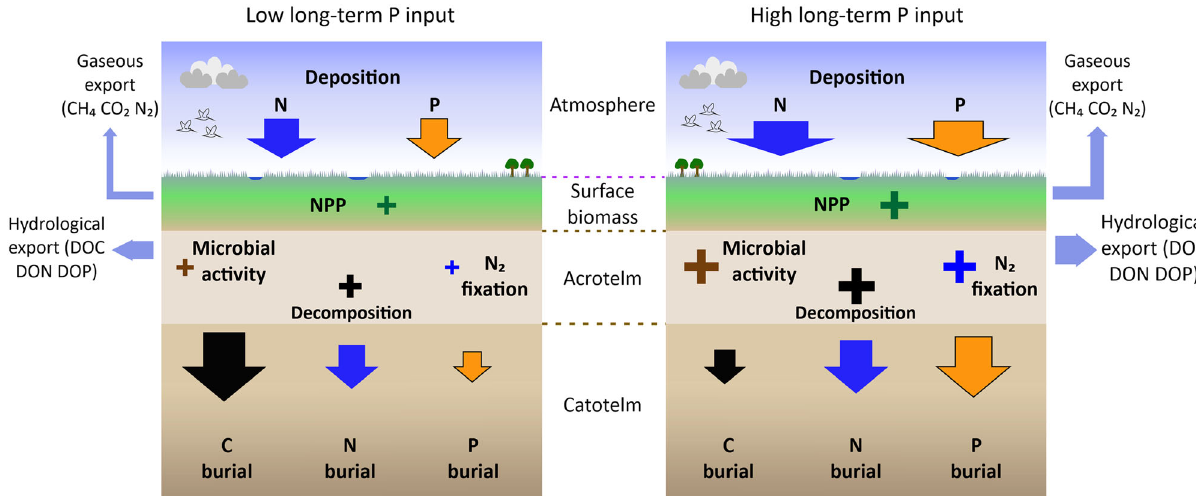
Fig. 6 Conceptual model illustrating the biogeochemical cascade in regions of low and high long-term P input. We propose that bogs in receipt of more P over the course of their development will, on average, bury less C. This is because higher nutrient input stimulates proportionally greater microbial decomposition, leading in turn to more gaseous and hydrological export from the acrotelm, than the fertilisation effects on surface productivity. See text for a more detailed explanation of the proposed governing mechanisms. Arrow sizes represent approximate proportions of input and output fl uxes. Crosses represent the relative magnitude of internal processes within the biogeochemical cascade. NPP = net primary productivity. DOC, DON and DOP = dissolved organic carbon, nitrogen and